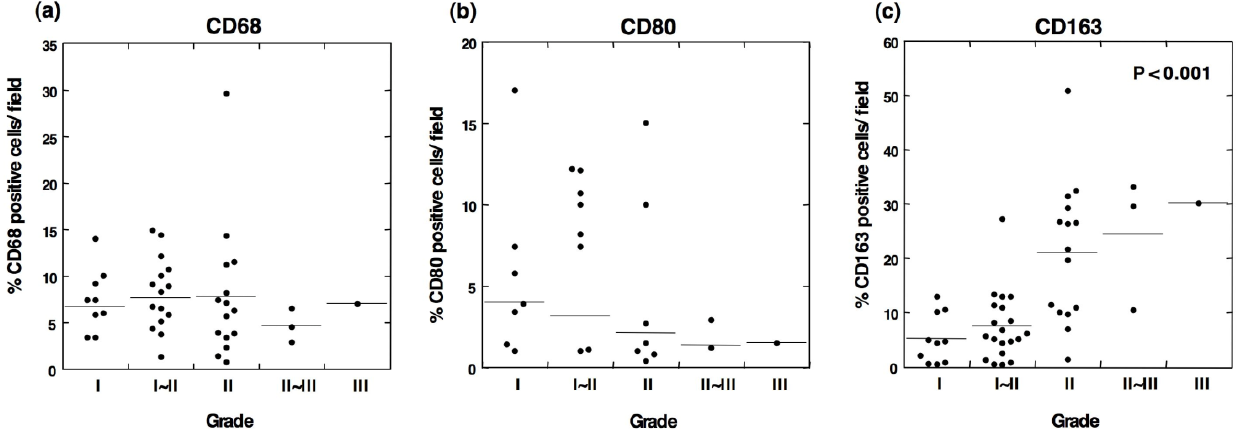
Figure 2. Analysis of infiltrating CD68-, CD80-, and CD163-positive cells in different histological grades of OSCC. Although CD68 + macrophages were observed in all grades of OSCC, no statistically significant differences were observed among the different tumor grades ( a ). Although the number of CD80 + M1 macrophages tended to be higher in the lower-grade tumors, no statistically significant difference was obtained ( b ). CD163 + M2 macrophages positively correlated with the tumor grade ( c ; p < 0.001, Kruskal-Wallis test).